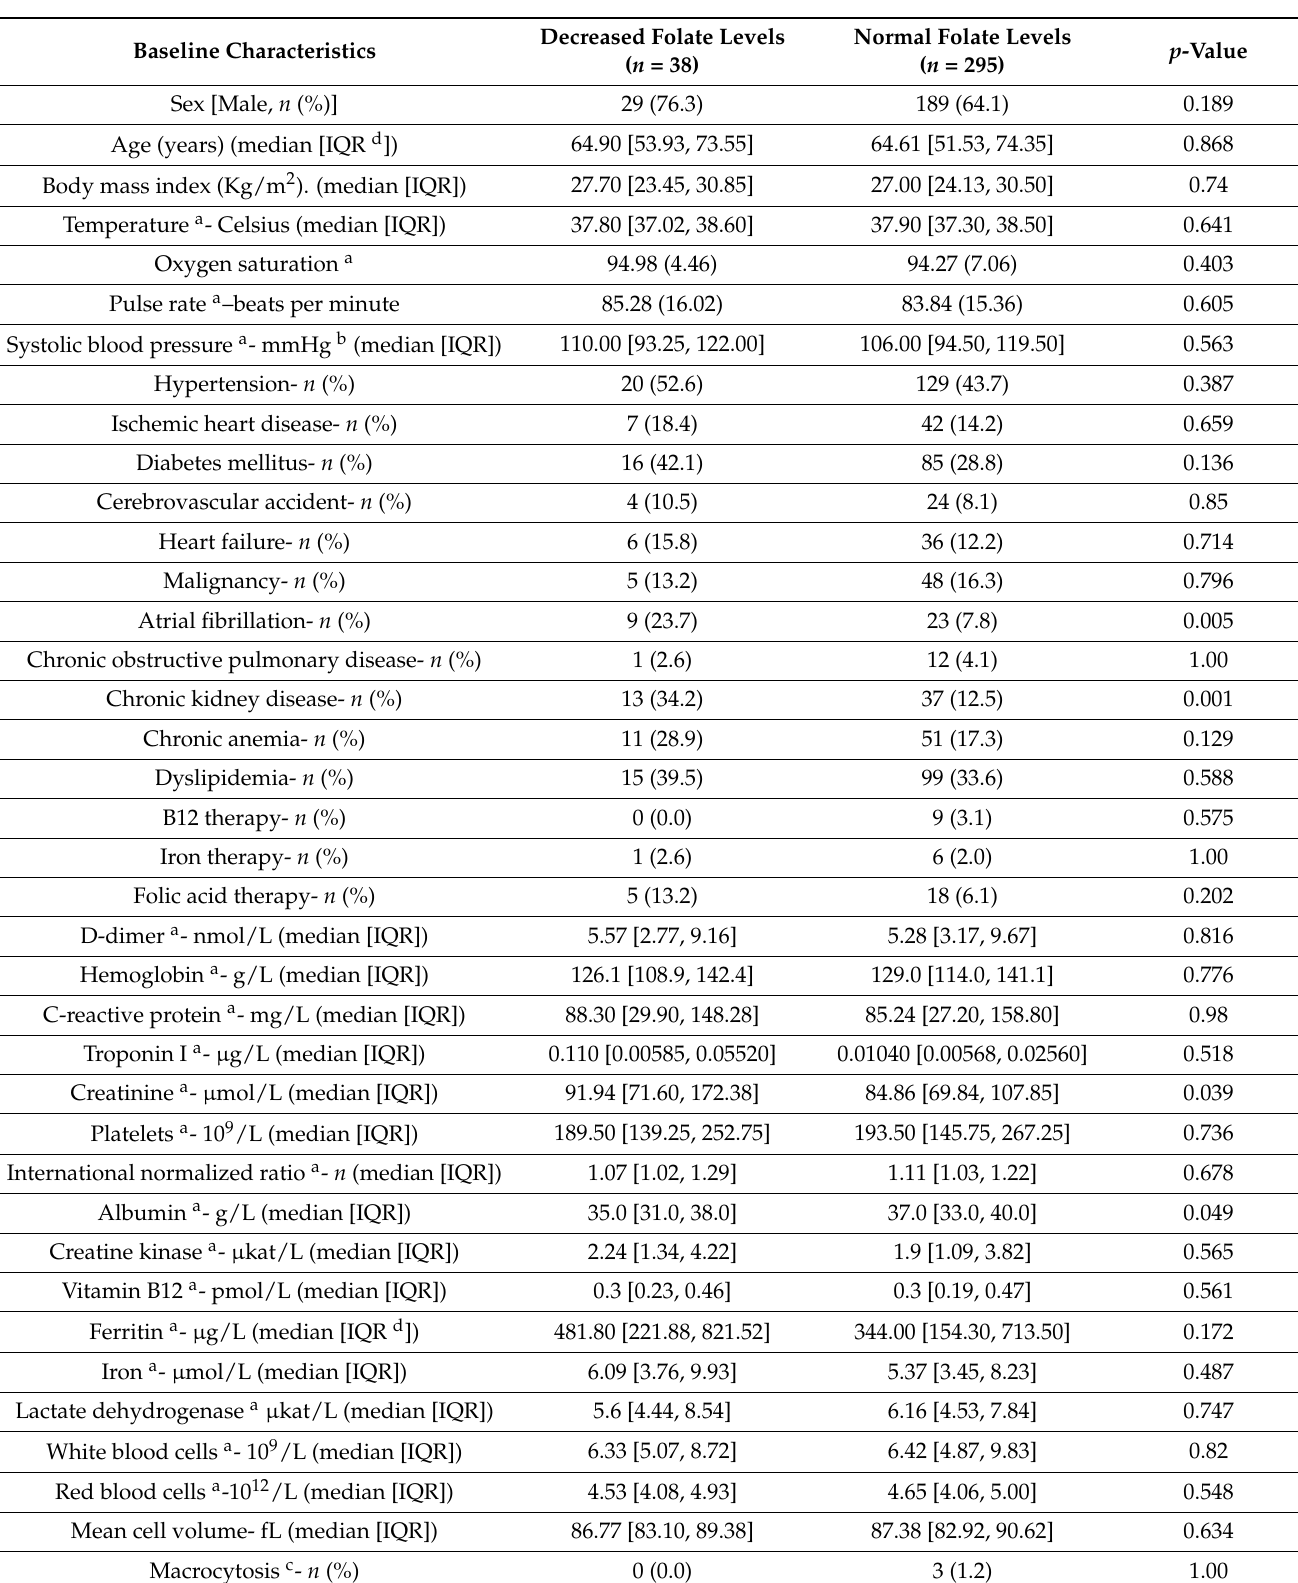
Table 1. Patients’ baseline